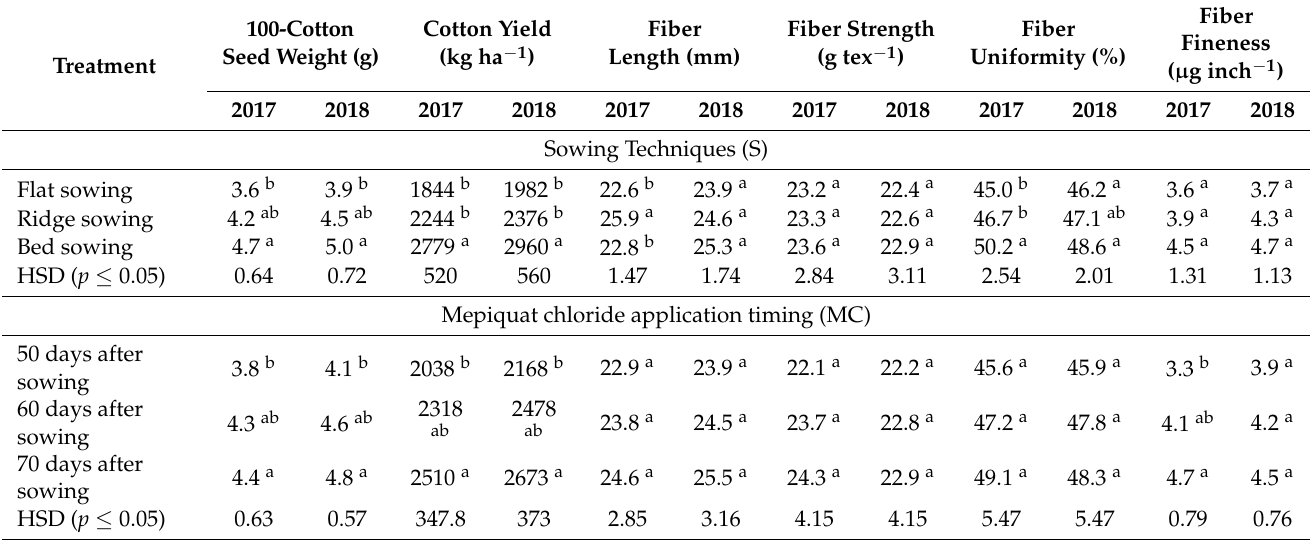
Table 3. Effect of different sowing techniques and timing of mepiquat chloride application on yield and lint quality-related attributes of